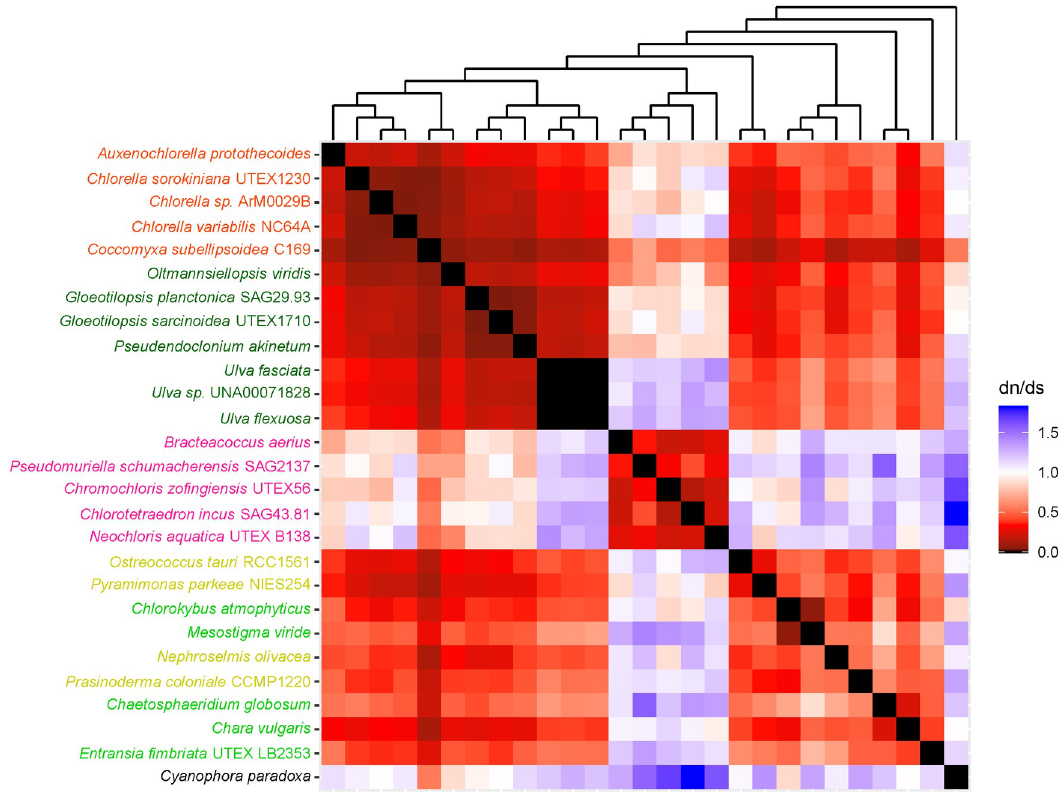
Fig 5. Heatmap of pairwise dN/dSdn/ds ratios calculated from alignment of plastid. The scale bar represents color corresponded to pairwise dN/dS ratios. The cladogram above the heatmap corresponds to phylogenetic relationship estimated using algal clp P.